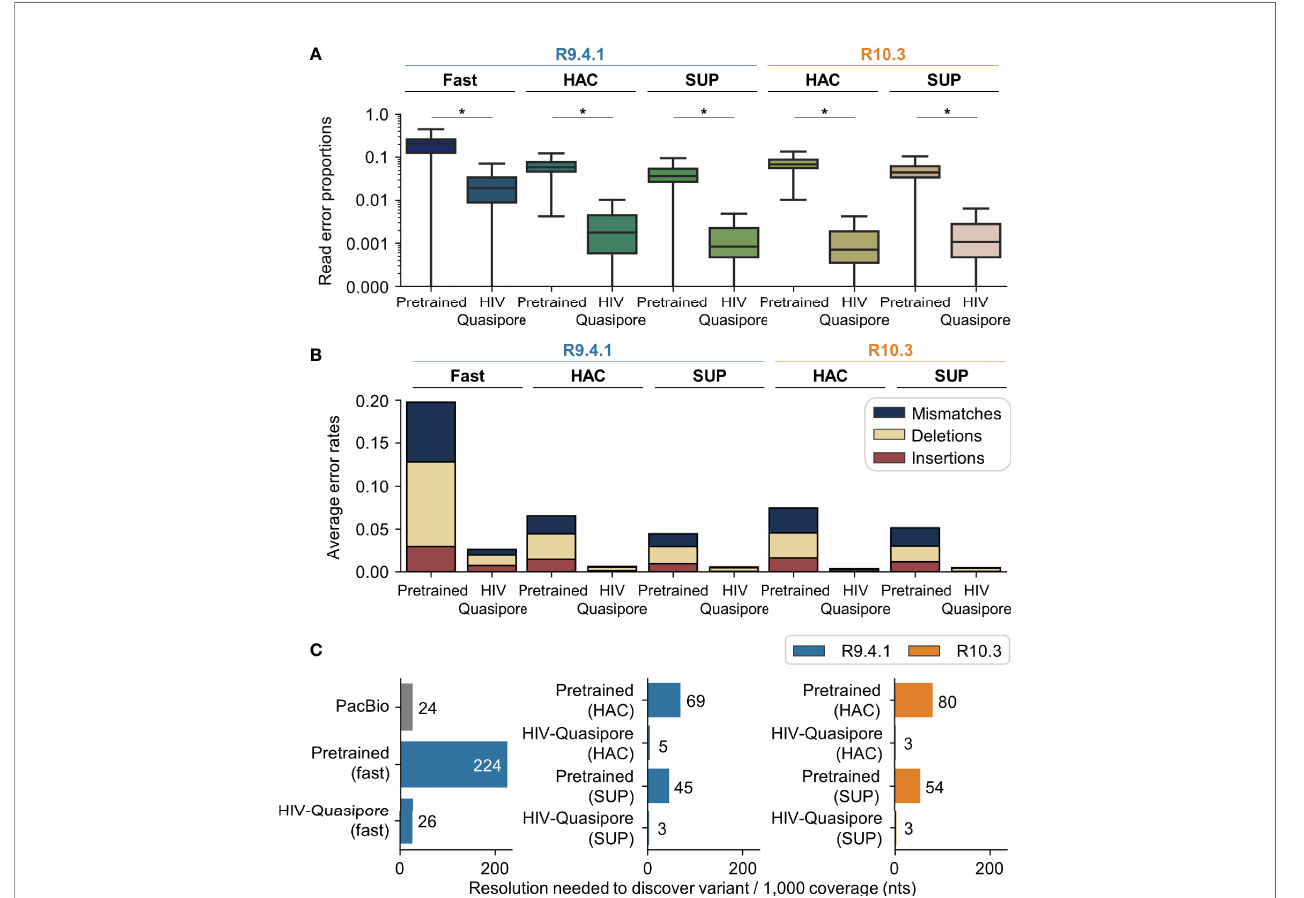
FIGURE 4 | HIV-Quasipore basecallers displayed lower error rates than pretrained basecallers and thus required less coverage to discover vQS. (A) Using HIV-Quasipore models signi fi cantly reduced basecalling errors (*p <0.05). (B) HIV-Quasipore basecaller mean error rates are lower than their pretrained counterparts. All error types were reduced, but read mismatches saw the largest drop in frequency in all models. (C) HIV-Quasipore lowered the minimum coverage needed to accurately call patient vQS per 1,000 coverage, as speci fi ed by the numbers after the bars (variant Q-score =